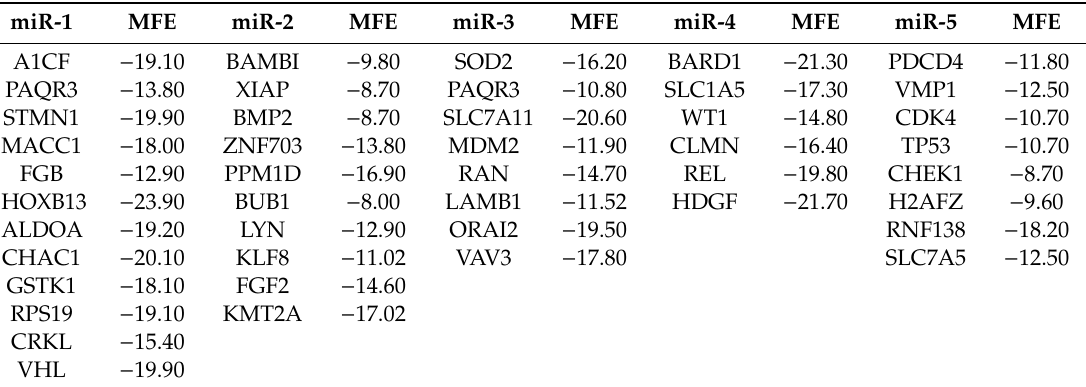
Table 2. MicroRNA target genes associated with colorectal cancer (CRC) and their MFE (miRTarBase).